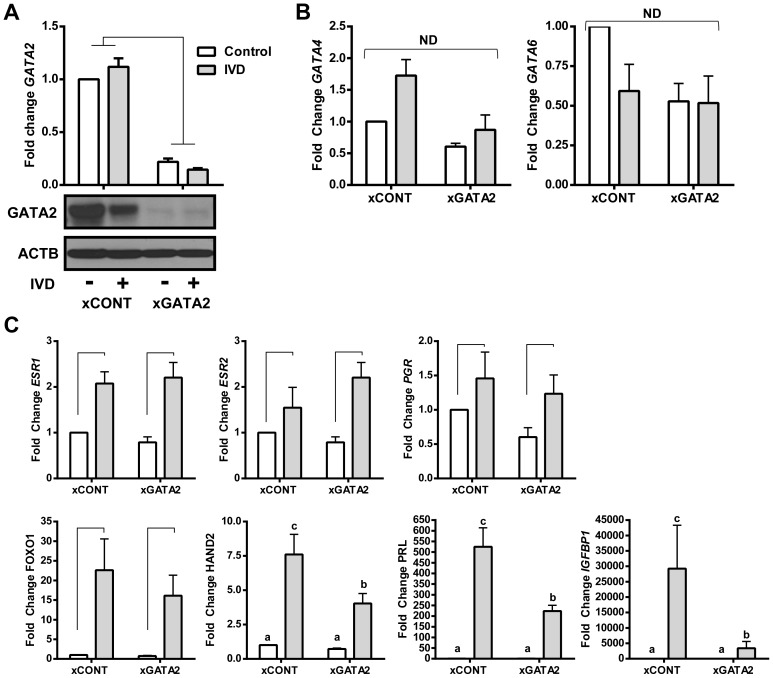
The effects of silencing GATA2 in EIUM.(A) Transfecting 50 nM of non-targeting control siRNA (xCONT) had little effect, but siRNAs targeting human GATA2 (xGATA2) effectively silenced GATA2 mRNA (qPCR; top), and protein (immunoblot; bottom). (B) Neither siRNA transfection nor IVD treatment significantly affected the expression of GATA4 or GATA6 mRNA, as shown by qPCR. (C) qPCR showed IVD was the main effect for altered expression of the steroid hormone nuclear receptors ESR1, ESR2, PGR, as well as FOXO1. However, the IVD-induced expression of decidualization markers HAND2, PRL, and IGFBP1 was significantly reduced in response to silencing GATA2. Other markers from our panel showed no change with any treatment (not shown). (n = 5; connecting bars show main effect p<0.05 by 2-way ANOVA; lower case letters indicate significantly different groups p<0.05 by Tukey's after ANOVA).